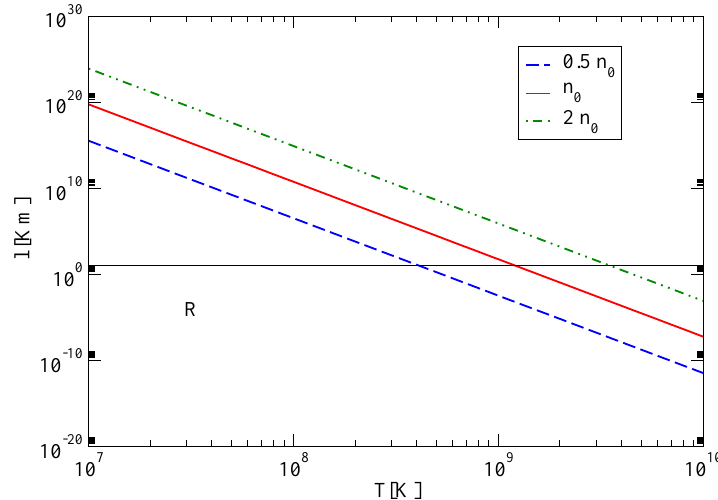
Figure 3. Upper panel : Shear viscosity in β -stable neutron matter for three densities as a function of temperature. Lower panel : Phonon mean free path in β -stable matter as function of temperature for three densities. The horizontal line indicates the radius of the neutron star of R = 10 km. Figures adapted from [6,18]. Adapted from [18] with the permission of AIP